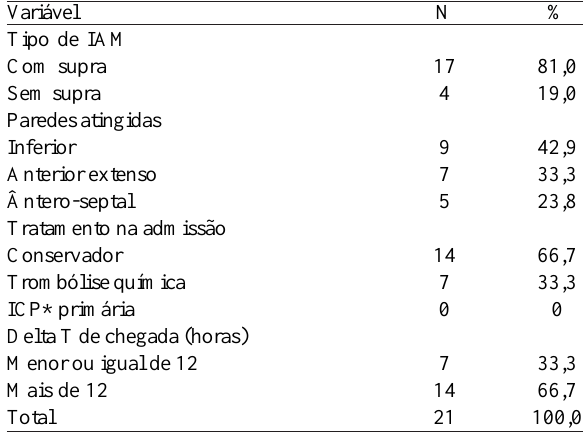
Tabela 2. Avaliação das variáveis: tipo de IAM, paredes atingidas pelo infarto, tratamento na admissão e delta T de